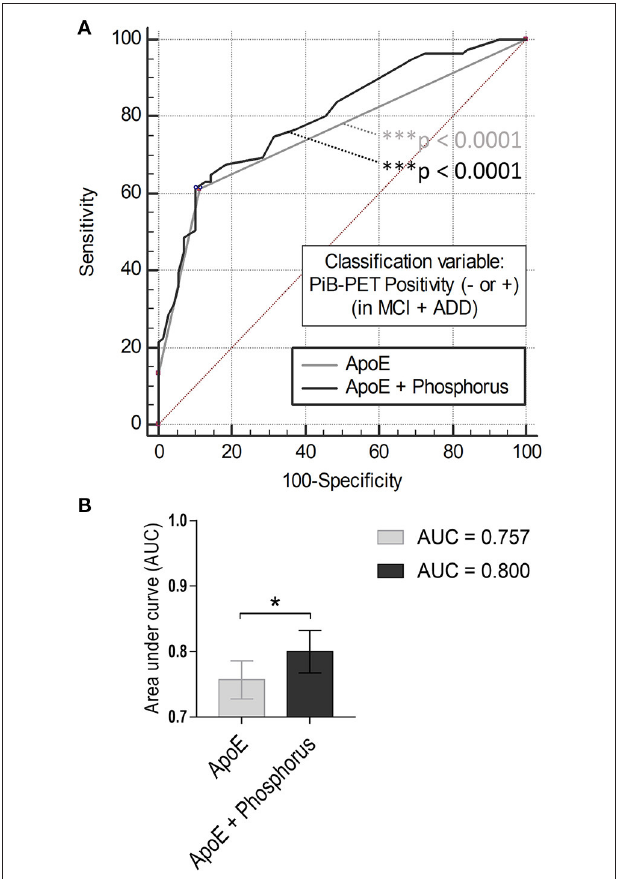
FIGURE 2 | Comparison of ROC curves analysis (A) ROC curve models using independent variables (ApoE ε 4 and/or serum phosphorus). Gray line (AUC: 0.757, *** p < 0.0001), ApoE alone; black line (AUC: 0.800, *** p < 0.0001). (B) Comparison of ROC curves analysis between the models (* p < 0.05, ApoE alone vs. ApoE with